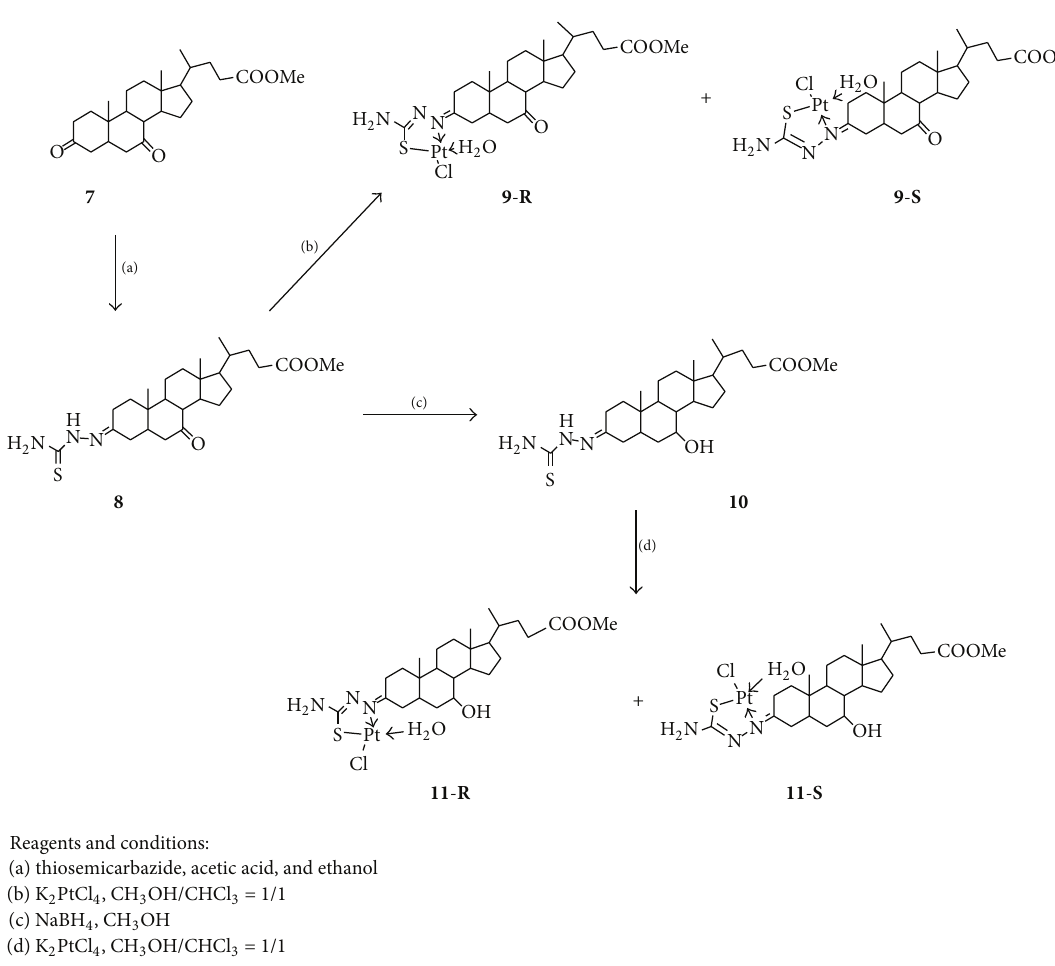
Scheme 2: Synthesis of methyl chenodeoxycholate complexes 9 and 10